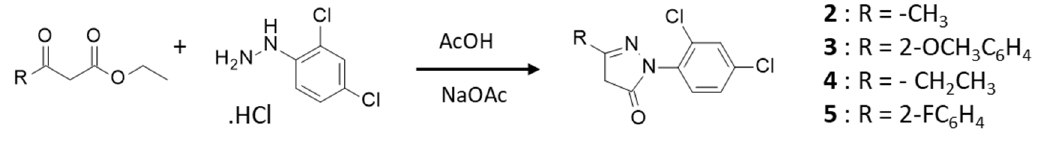
Figure 2. Synthetic scheme common to compounds 2 – 5 . It consists in the reaction of 2,4-dichlorophenyl-hydrazine with the indicated β -keto ester in the presence of sodium acetate, for 48 h at room temperature.